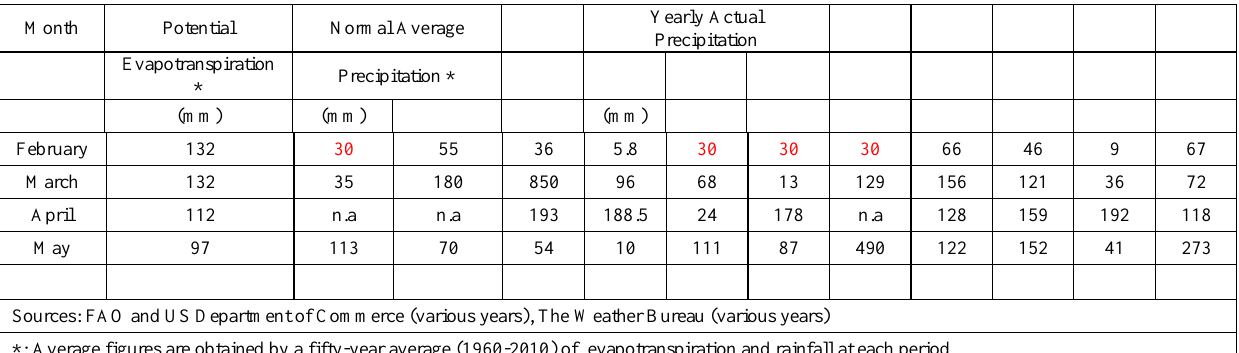
Table 2 (cont.). Potential Evapotranspiration and Precipitation Near Eldoret (in West Kenya)